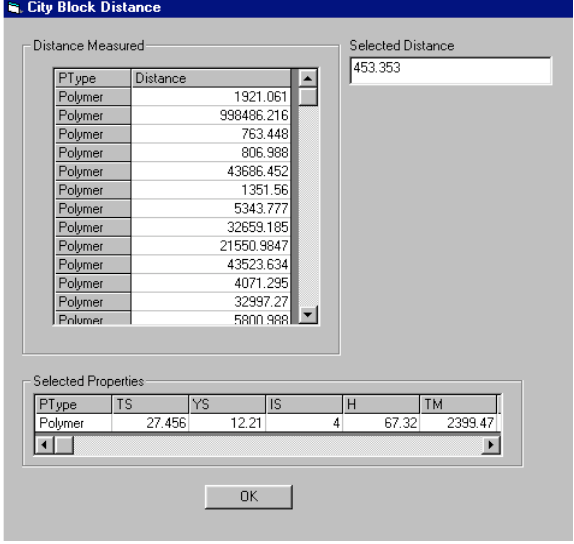
Fig. 6(a): Materials selected using City-Block Distance